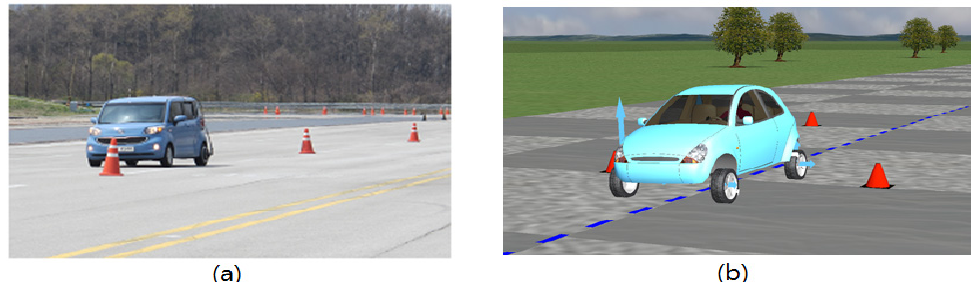
Figure 5. Comparison with experiment and simulation under double lane change test condition; ( a ) experiment; ( b ) simulation using CarSim.